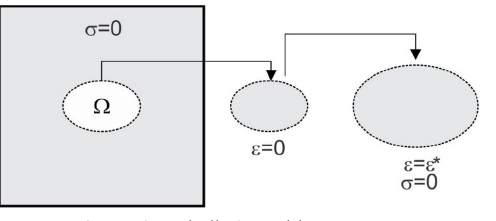
Figure 3: Eshelby's problem strategy.